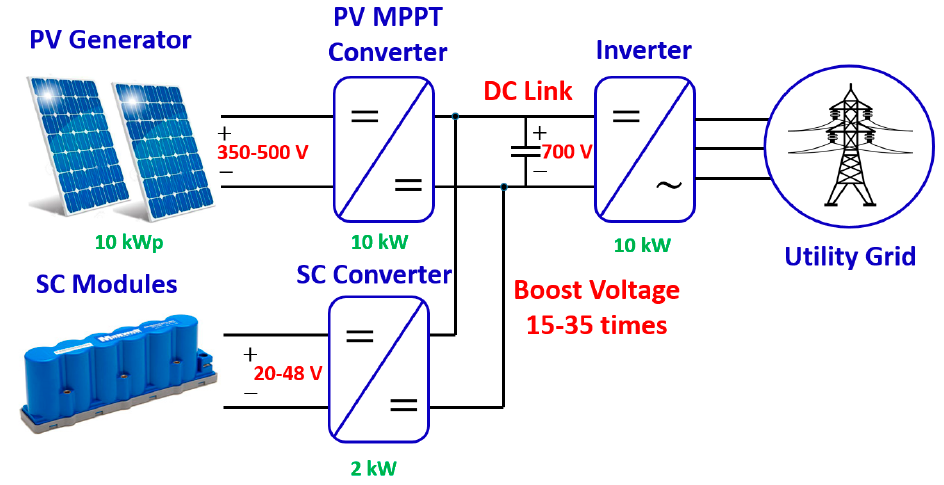
Figure 1. Classical approach to connecting SC to the main DC-link of the inverter using a very high-gain converter for the 10 kWp PVS.